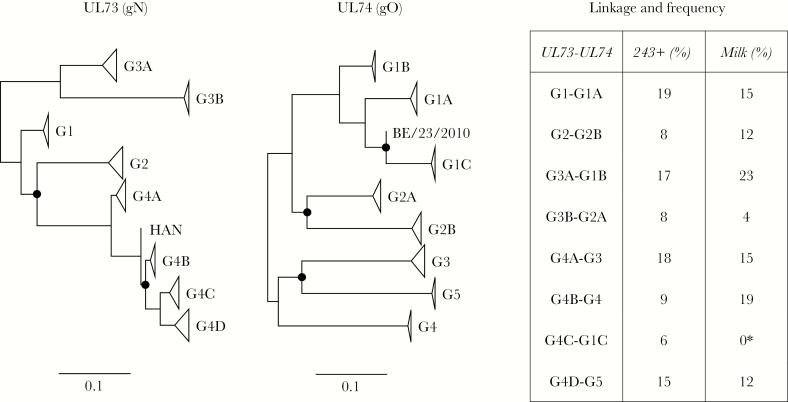
Unrooted phylogenetic trees for UL73 and UL74 based on amino acid sequences derived from 243 genome sequences, and a summary of genotypic linkages and frequencies. The site coverage cutoff value was 95%, leaving 134 sites in the UL73 tree (log likelihood, –1117.87) and 435 sites in the UL74 tree (log likelihood, –4153.86). Branch point robustness was inferred from 100 bootstrap replicates, and values of <70% are denoted by filled circles. Genotype branches are collapsed, and the numbers of substitutions per site, are shown by the scale. The UL73 sequence of strain HAN and the UL74 sequence of strain BE/23/2010 did not fall into the genotypes. The linkages between UL73 and UL74 genotypes are listed, followed by the frequencies of UL73 genotypes in the 243 genome sequences plus 383 single-gene sequences (243plus; 626 in total; Table 2), and the frequencies of the deduced linkages in the samples (milk; 26 in total; Table 3). The frequency of each genotype in the milk set was not significantly different (above P = .05) from that in the 243 plus 383 single gene set, as determined by random subsampling analysis (10 000 samplings of 26 genotypes from the set of 626). *Although no examples of this linkage were present in the datasets at levels in excess of the thresholds, at least one patient (258) was infected at subthreshold levels by a relevant strain (Supplementary Table 1).